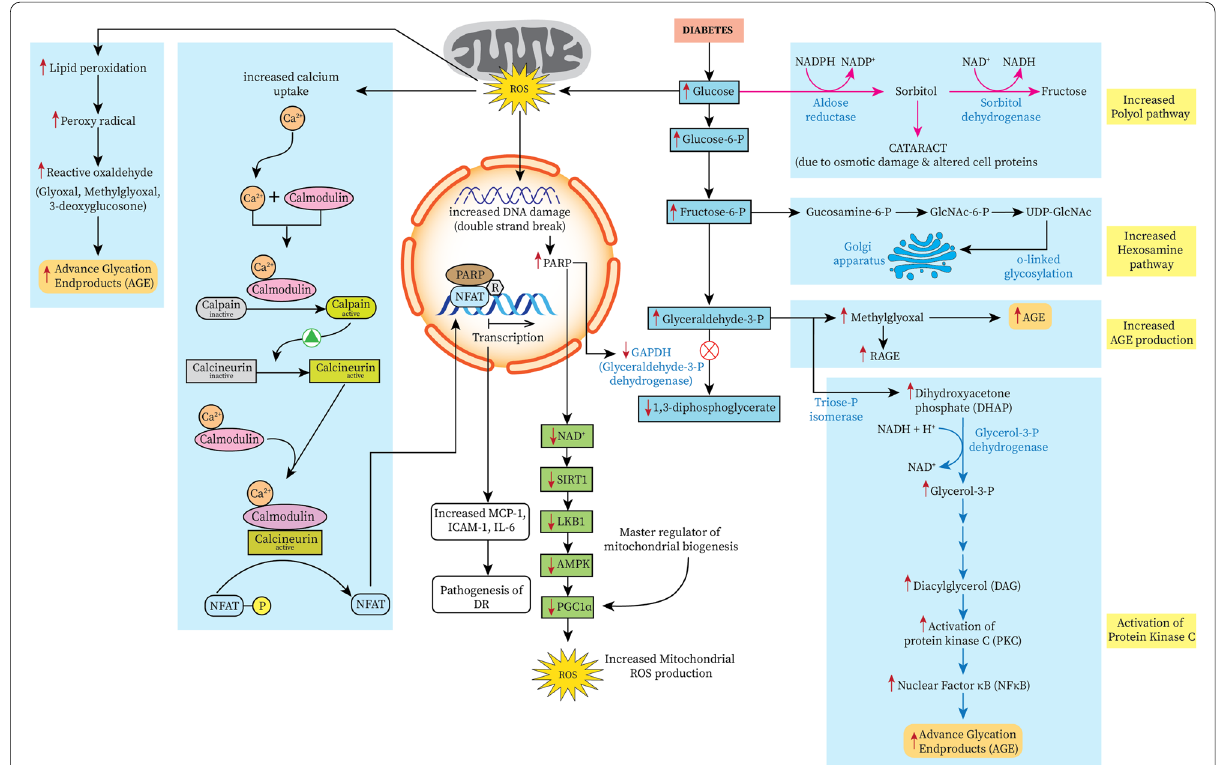
Fig. 1 Hyperglycemia-mediated activation of various biochemical pathways. Reactive oxygen species generated due to hyperglycemia increase the transcription of various downstream signalling pathways by damaging the structure of DNA. This halts the normal pathway of glycolysis so that its substrates are diverted to other biochemical pathways. Glyceraldehyde 3 phosphate isomerizes to dihydroxyacetone phosphate (DHAP) that increases the production of advanced glycation end products. Activation of the hexosaminase pathway causes increased o glycosylation of glycolytic substrates. Activation of pyruvate kinase pathway, especially pyruvate kinase beta and NFAT pathway upregulation causes further activation of cytokines, chemokines, and interleukins, having deleterious effects on the cells of the retina, all of which is responsible for the changes of diabetic retinopathy. Activation of the polyol pathway leads to increased production of sorbitol and fructose, which are hyperosmotic agents and are implicated in the causation of diabetic cataract. As glyoxylase enzyme is generally overexpressed in the endothelium, AGE accumulation in the vessel wall is less. However, this detoxification system is deficient in people with diabetes, causing more pericyte apoptosis and thus accentuating DR